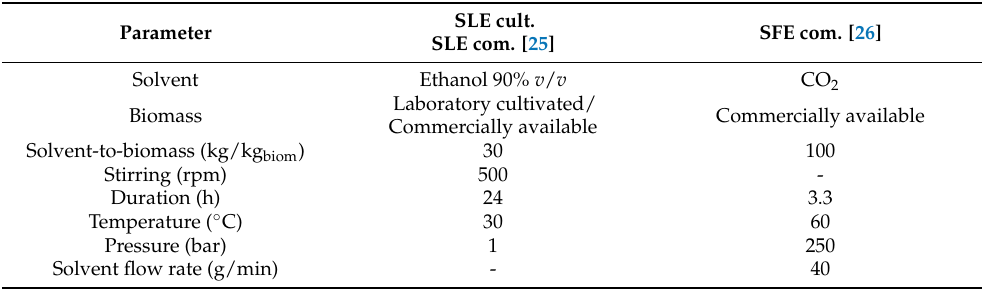
Table A1. Optimum operational conditions of SLE and SFE. Parameter